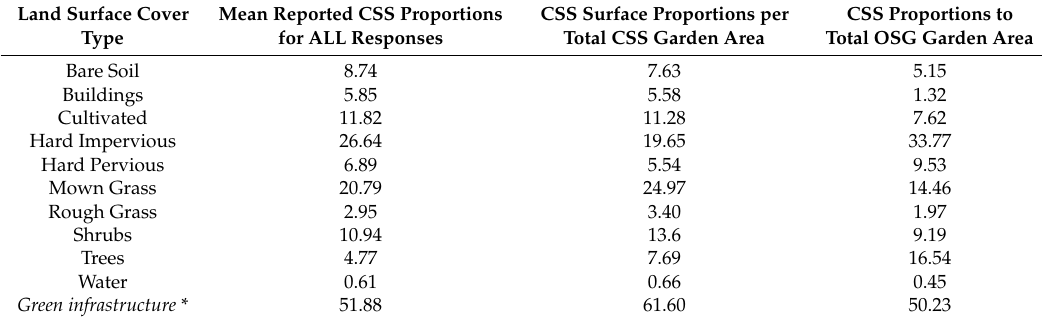
Table 9. Comparison between CSS surface proportion estimates, CSS surface proportions per total CSS garden area and extrapolated CSS proportions within final